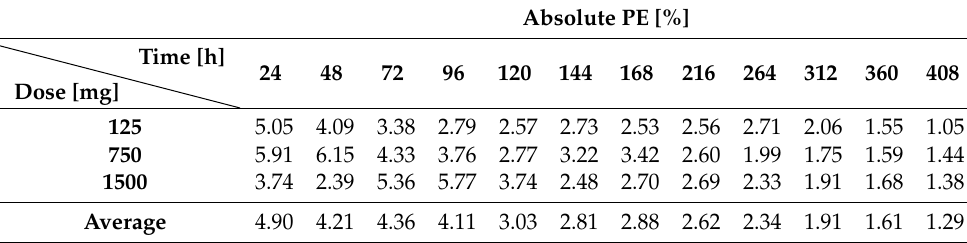
Table A3. Absolute %PEs on C max for IVIVC P-ring model identified on dose 125, 750, and 1500 mg. Dose [mg]